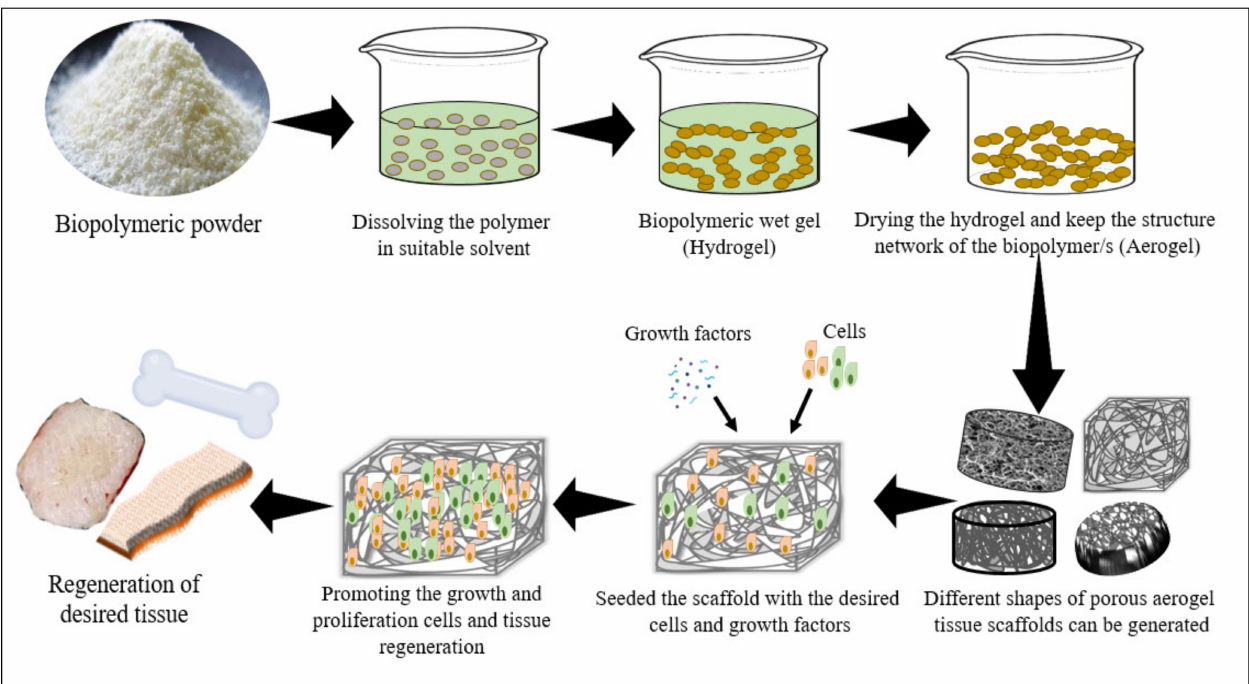
Figure 3. Schematic illustration of the original principle of using biopolymer aerogel scaffolds in tissue